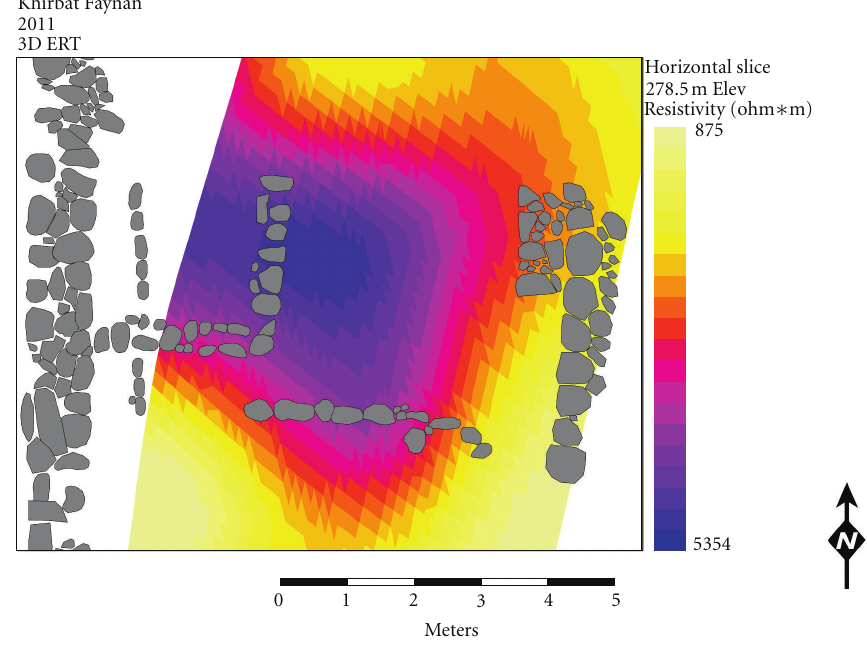
Figure 6: Walls found during the excavation superimposed on a horizontal ERT slide at 1m